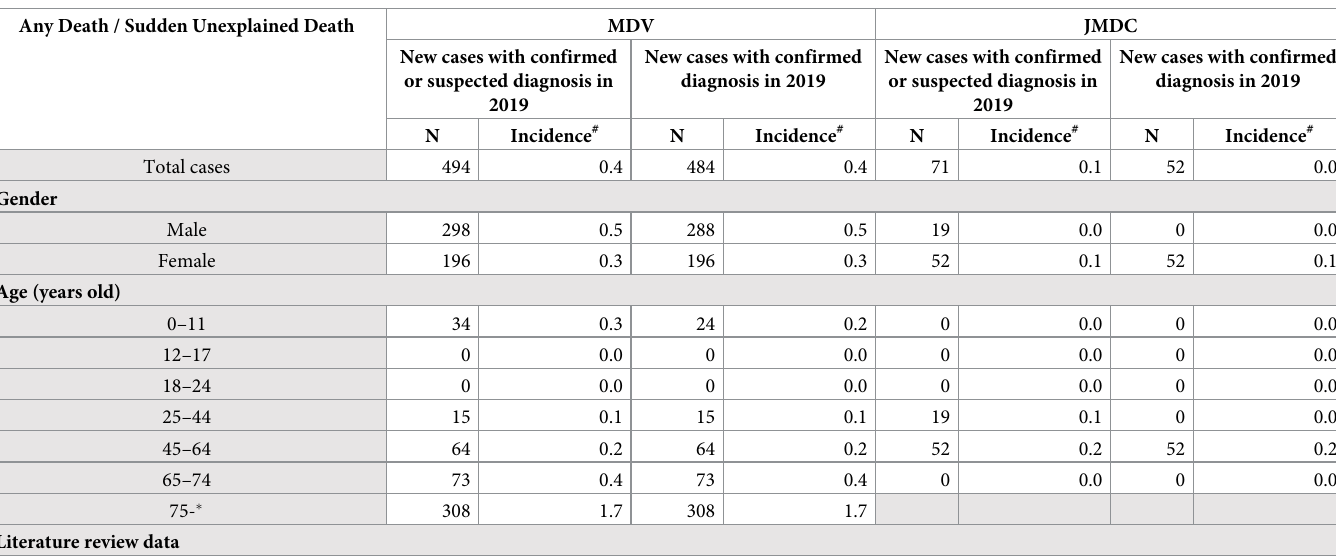
Table 10. Estimated incidence of Any Death/Sudden Unexplained Death. Any Death / Sudden Unexplained